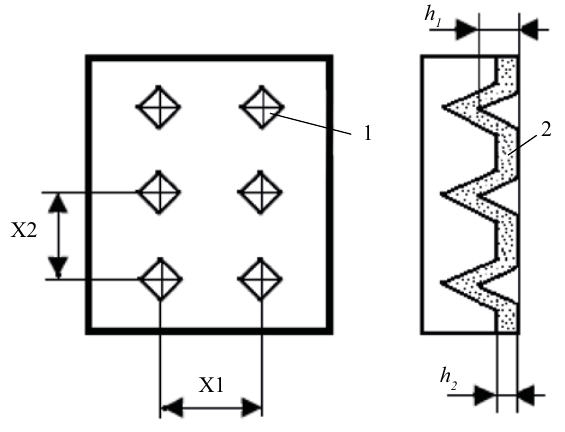
Fig. 1. General diagram of a discrete surface with dimples strengthened with ion nitriding: 1 – dimple; 2 – coating; h 1 – dimple depth; h 2 – coating thickness; Х1 – distance between rows; Х2 – distance in the row